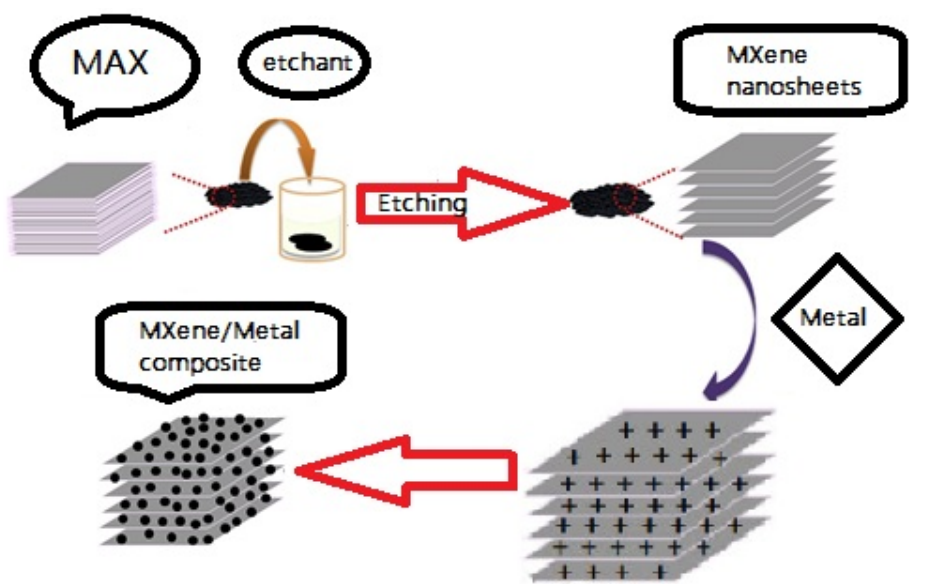
Figure 1. Schematic illustration of MXene and metal composite synthesis procedure.